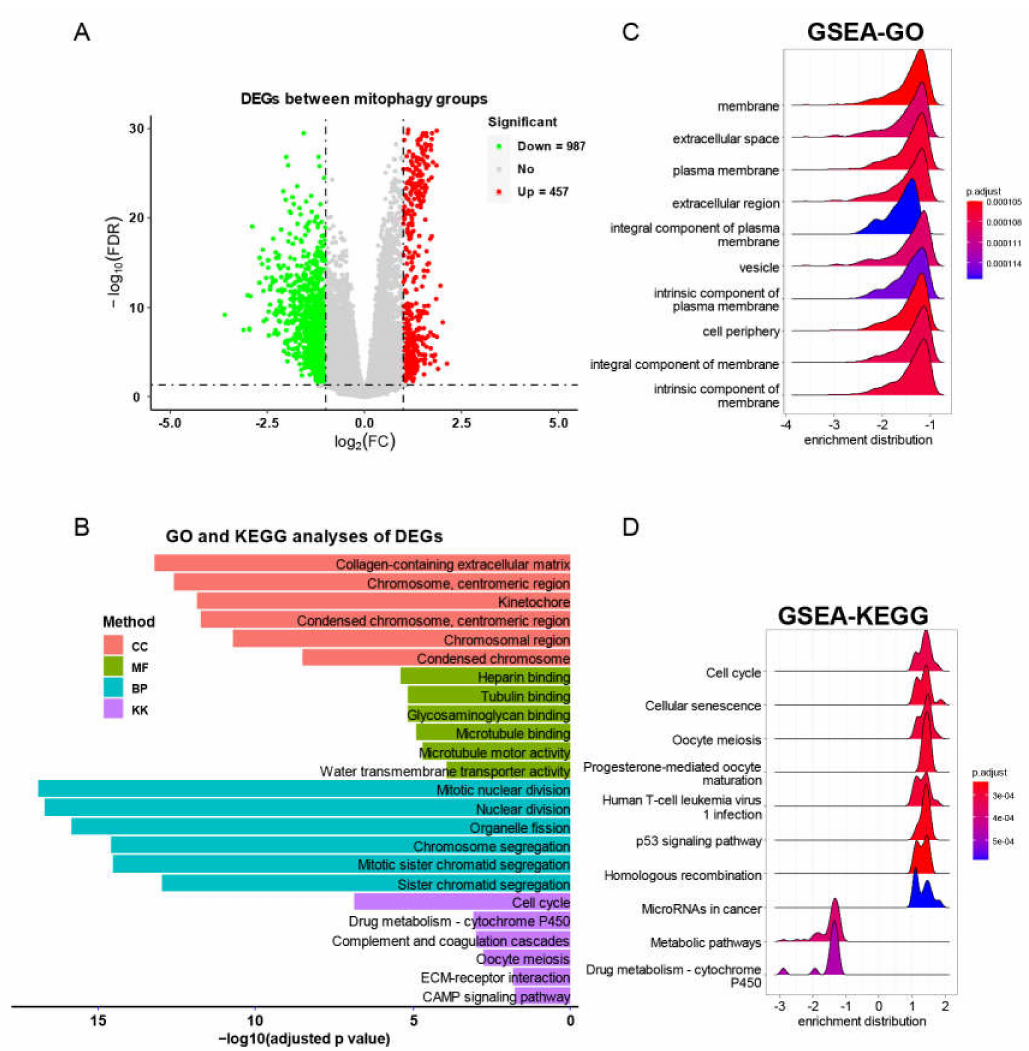
Figure 8. The DEG identification and related functional analyses. ( A ) The volcano plot of DEGs between mitophagy groups. ( B ) The GO and KEGG analyses of DEGs between mitophagy groups. ( C , D ) The GSEA of DEGs by GO ( C ) and KEGG ( D )